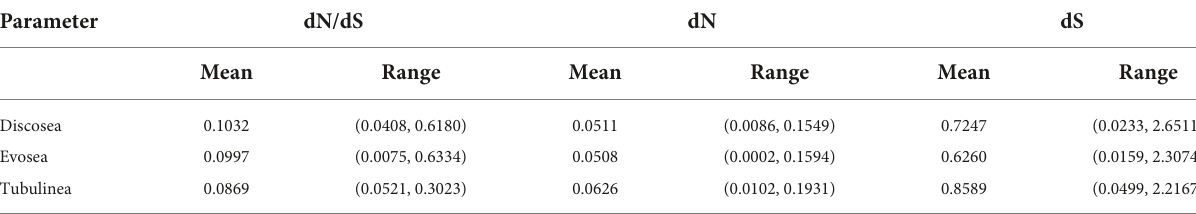
TABLE 2 Statistics of parameters based on the results of branch model M1 (free ratio) across all the branches in each major clade. Parameter